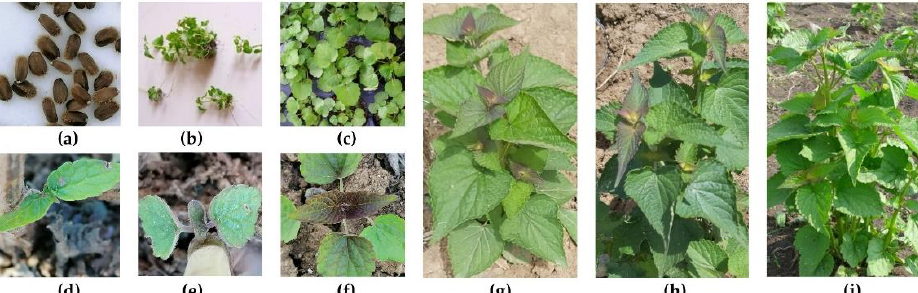
Figure 3. Vegetative growth stages of Agastache species studied according to BBCH scale; in the first year: ( a ) stage 00, ( b ) stage 09, ( c ) stage 12; in the second year: ( d ) stage 08, ( e ) stage 09, ( f ) stage 13; stages common in both years ( g ) stage 24, ( h ) stage 29, ( i ) stage 35; (original).